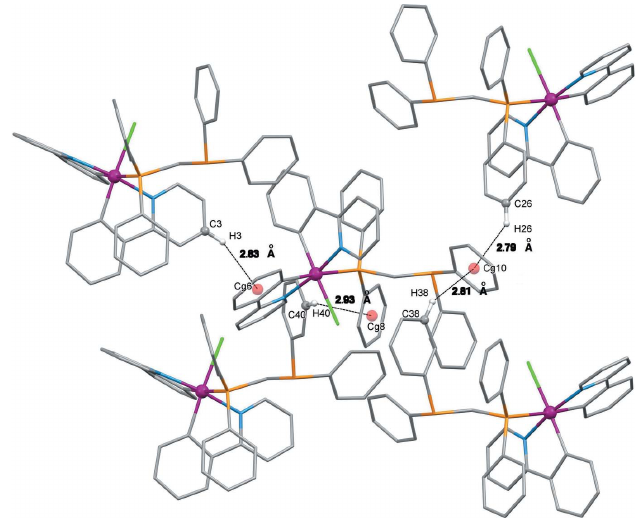
Figure 4 The intermolecular C—H (cid:3)(cid:3)(cid:3)(cid:3) (cid:3) interactions in the title